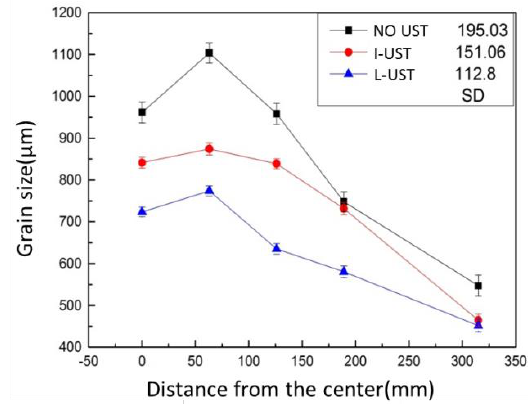
Figure 7. Of grains in the radial direction of the three ingots.